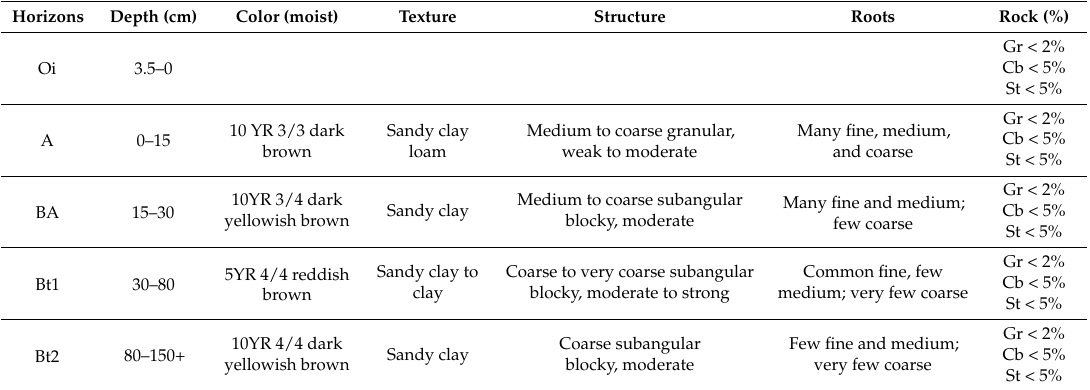
Table 2. Typical soil profile description. Resembles Cumley series (a Palehumult). Average slope of (>25 cm); YR,